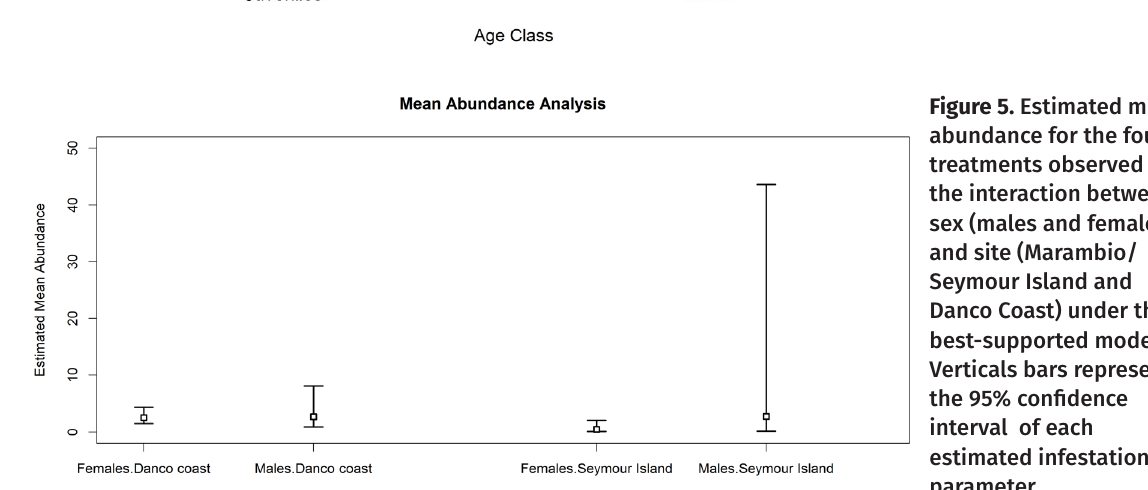
Figure 4. Estimated mean abundance for both juvenile and adult Weddell seals under the best-supported model. Verticals bars represent the 95% confidence interval of each estimated infestation